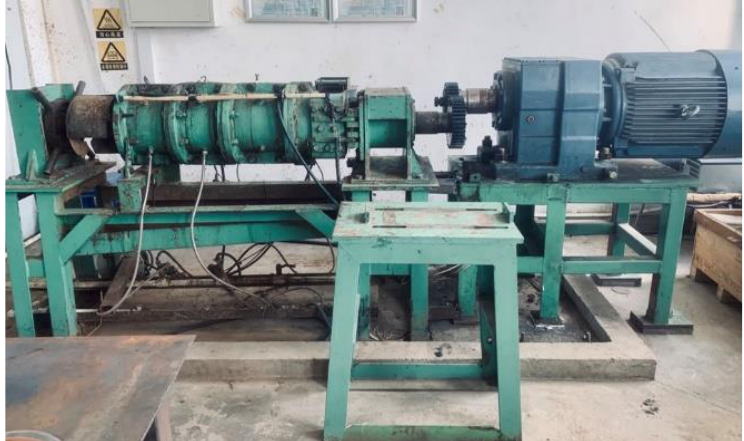
Figure 8. D200 straw fiber making machine.